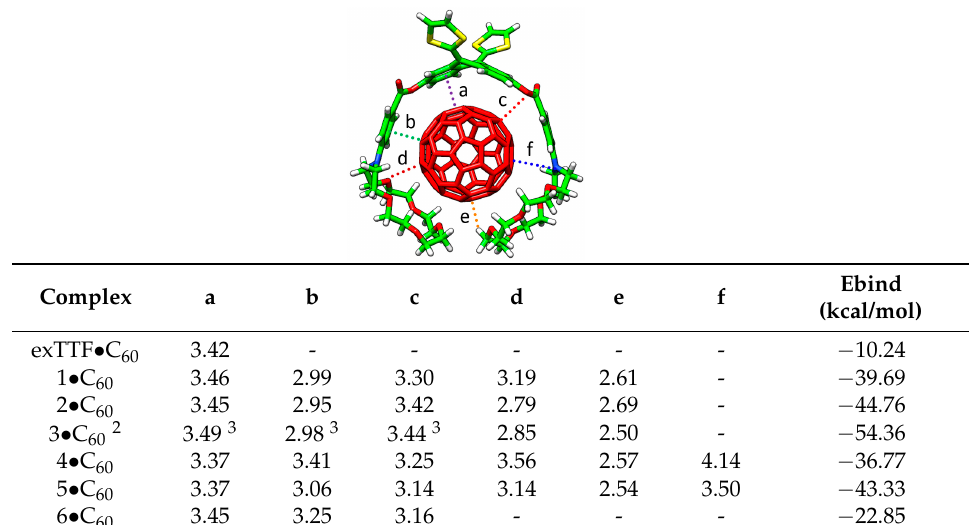
Figure 5. B97-D/cc-pVDZ minimum-energy geometries calculated for the exTTF•C 60 and 1 – 6• C 60 complexes. The electron-acceptor C 60 is colored in red whereas the sulfur, carbon, oxygen and hydrogen atoms in the electron-donor system are colored in yellow, green, red and white, respectively. Table 2. Intermolecular distances ( a – f , in Å) and binding energies ( E bind , in kcal/mol) calculated at the B97-D/cc-pVDZ and revPBE0-D3/cc-pVTZ levels, respectively, for the exTTF•C 60 and 1 – 6 •C 60 complexes [84] 1 .